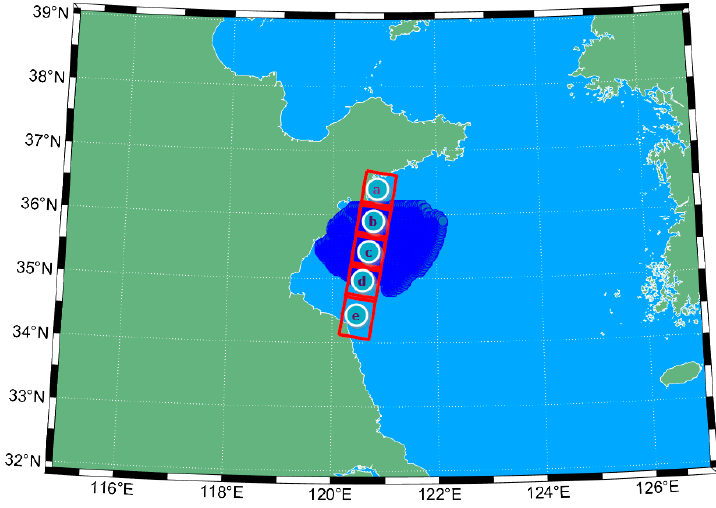
Figure 1. GF-3 satellite observation area (red) and HFSWR measurement area (blue) in the experiment conducted in Qing Dao in 2022.